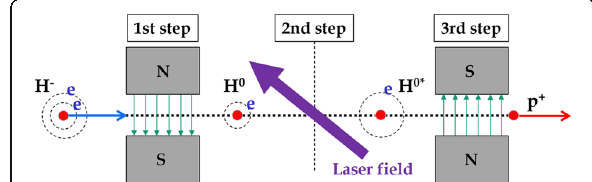
Fig. 25 Schematic of the laser stripping method Fig. 23 Schematic of the laser-assisted stripping